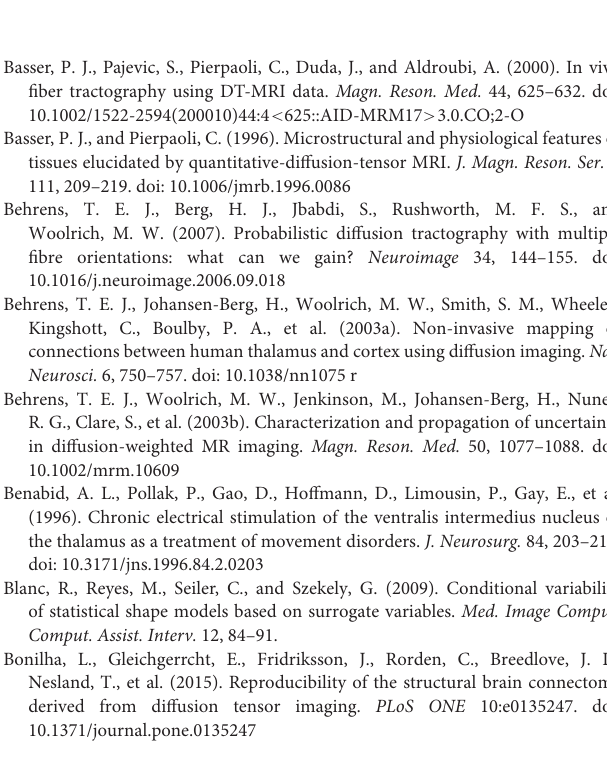
FIGURE S1 | The statistical shape model based atlas of the human thalamus used in our study. FIGURE S2 | Reconstruction of the CTT using diffusion tractography. 3D visualization of the seed and waypoint target regions used during fiber